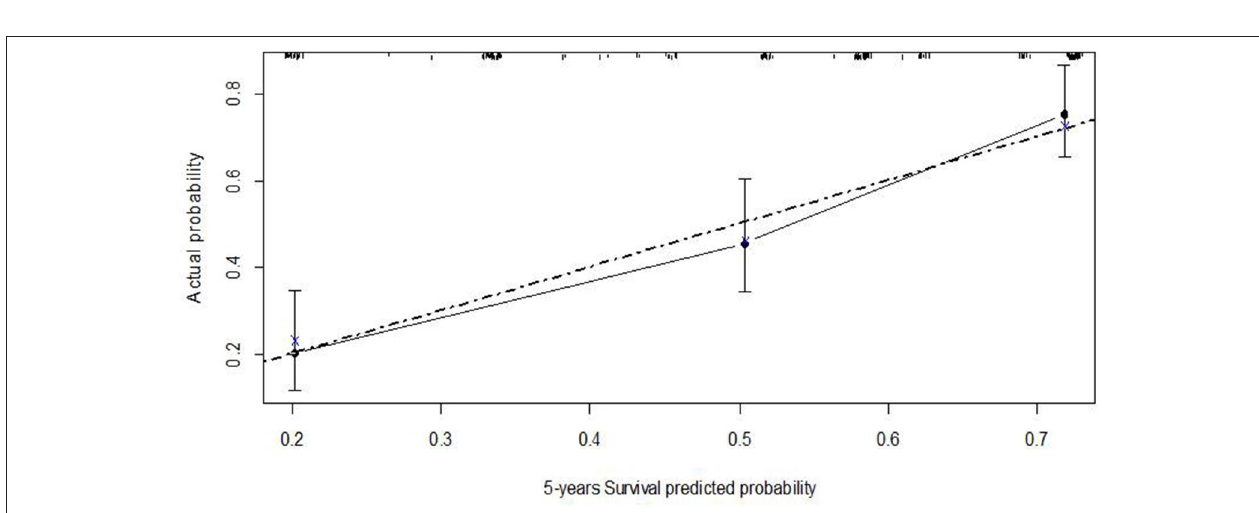
FIGURE 4 | Calibration plot of the Cox regression model of recurrence-free survival at five years–nomogram